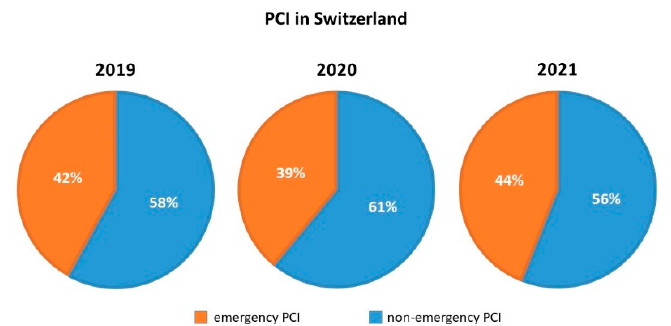
Figure 2. Proportions of emergency and non-emergency PCIs pre (2019), during (2020) and post (2021) the peak of the COVID-19 pandemic. (PCI—percutaneous coronary intervention, including preceding diagnostic angiography).